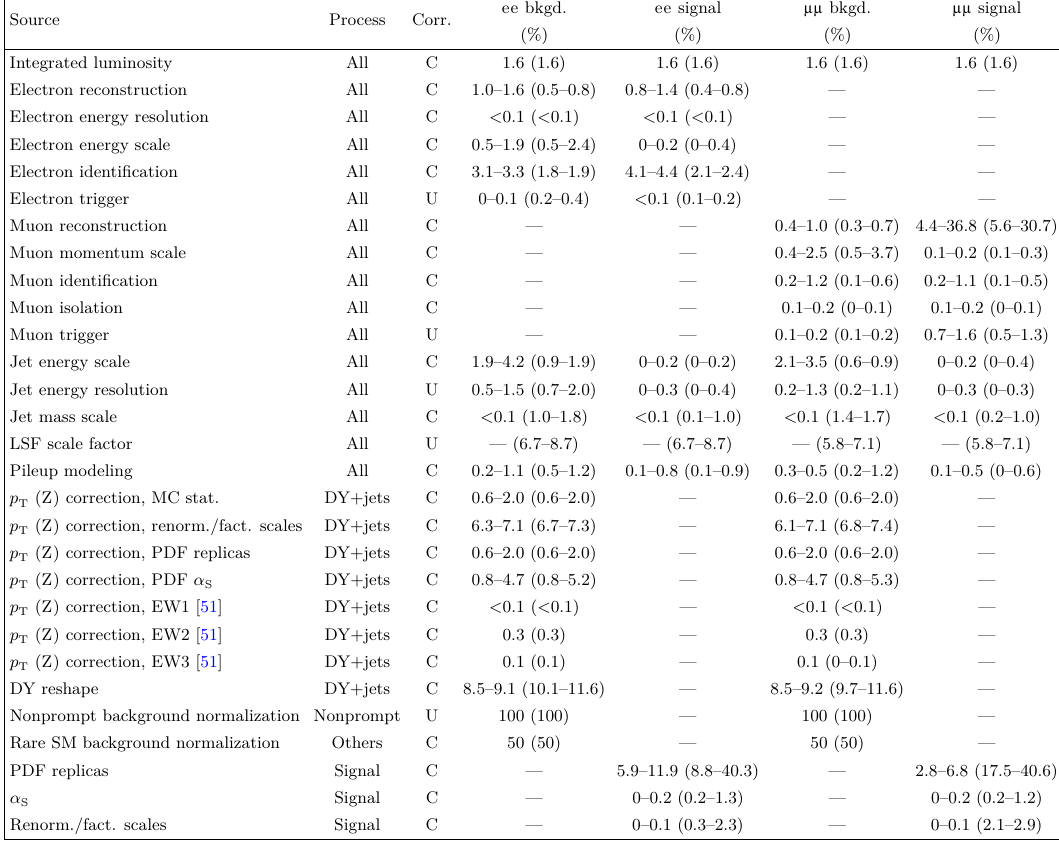
Table 1 . Summary of the relative uncertainties in the total yields of the signal and background (bkgd) predictions. The uncertainties are given for the resolved (boosted) SR. The values for the signal correspond to m = 5 TeV. The range given for each systematic uncertainty source covers WR the variation across the years and the year-to-year treatment is shown as either fully correlated (C) or uncorrelated (U). The EW1, EW2, and EW3 entries are the uncertainties from the O ( α 2 ) Sudakov terms, the NLO portion of the nNLO EW uncertainty, and the uncertainty in the Sudakov approximation at nNLO,